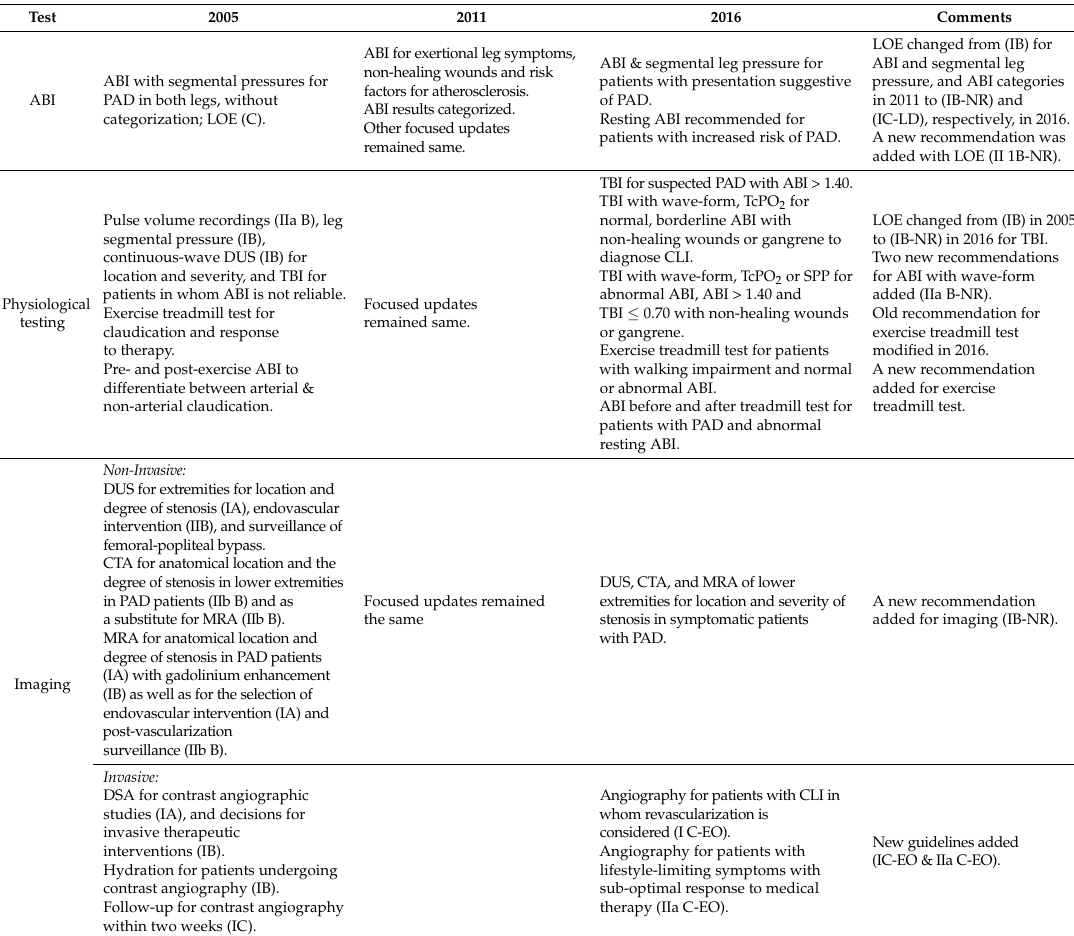
Table 2. Comparison between guidelines 2005, 2011 and 2016 in terms of diagnostic